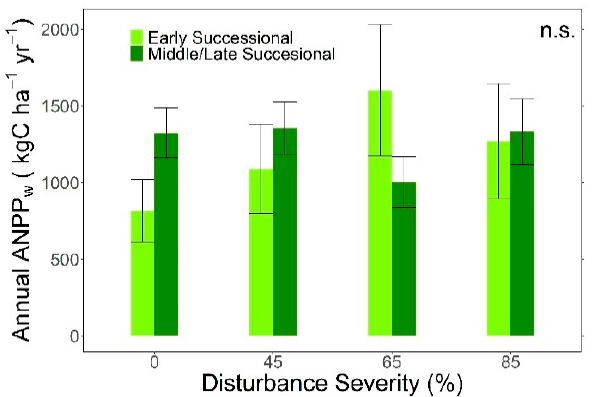
Figure 6. The contribution of early and middle to late successional species cohorts from all canopy strata to annual aboveground wood net primary production (ANPP w , ± 1 S.E.) at each disturbance severity treatment. Error bars are the SE of mean annual ANPP w among treatment replicates. Significant differences ( α = 0.05) between successional cohorts among disturbance severities were not detected (n.s.).